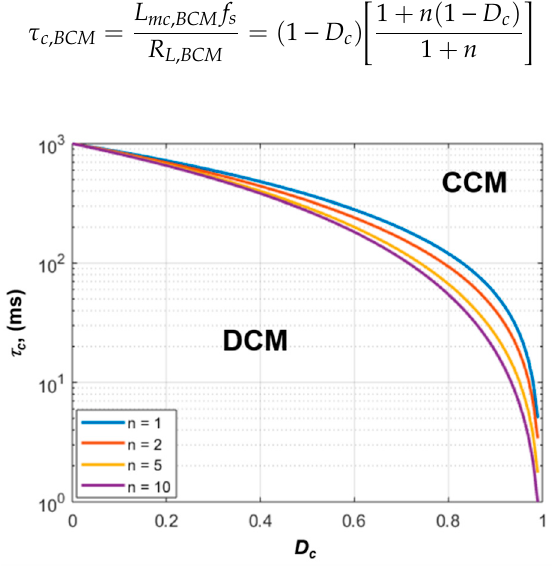
Figure 9. The curve of the boundary time constant τ c,BCM in the charge mode.